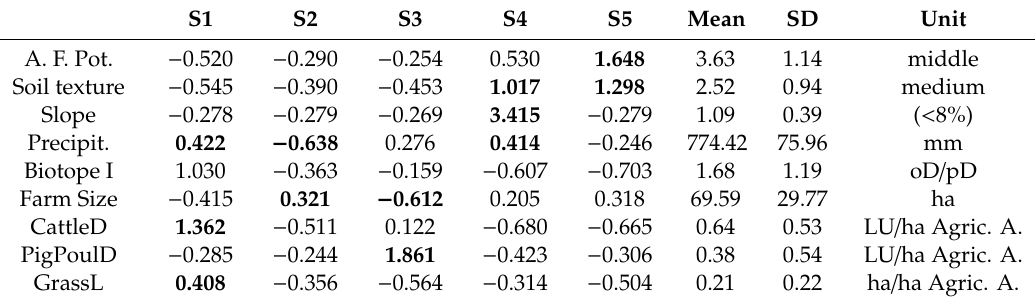
Table 4. Mean values per cluster of the k-means clustering for site variables (S1, S2, S3, S4, and S5—corresponding map in Figure 3a). Values are z-standardized and represent how strong the standard deviation di ff ers from the mean value ( µ = 0.000). A small value shows no significant di ff erence from the mean value. The positive and negative values represent the direction of deviation from the mean value in that cluster.